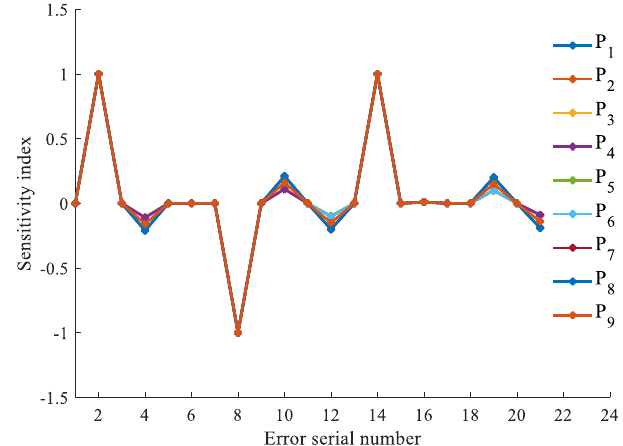
Figure 4. Sensitivity index of position error in the y direction.